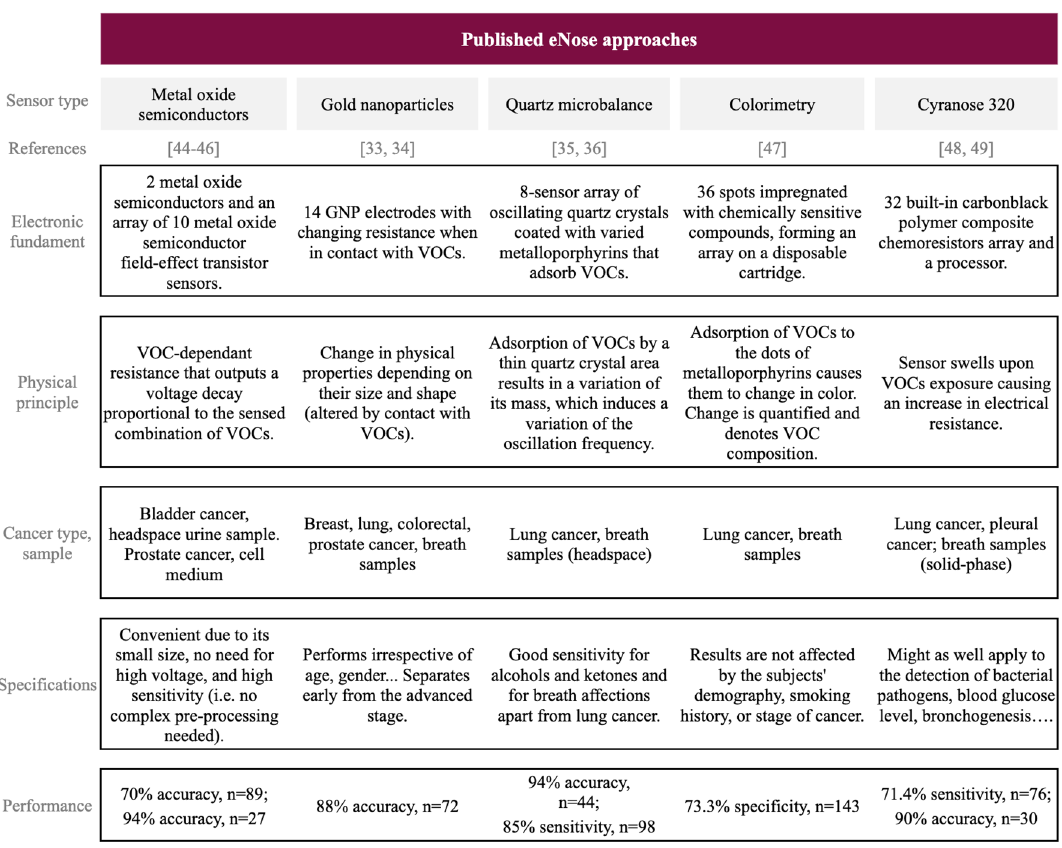
Figure 1. Summary of published eNose approaches to portable low-cost screening solutions: Metal oxide semiconductors 43–45 , gold nanoparticles 34,35 , quartz microbalance 36,37 , colorimetry 46 and the Cyranose 320 47,48